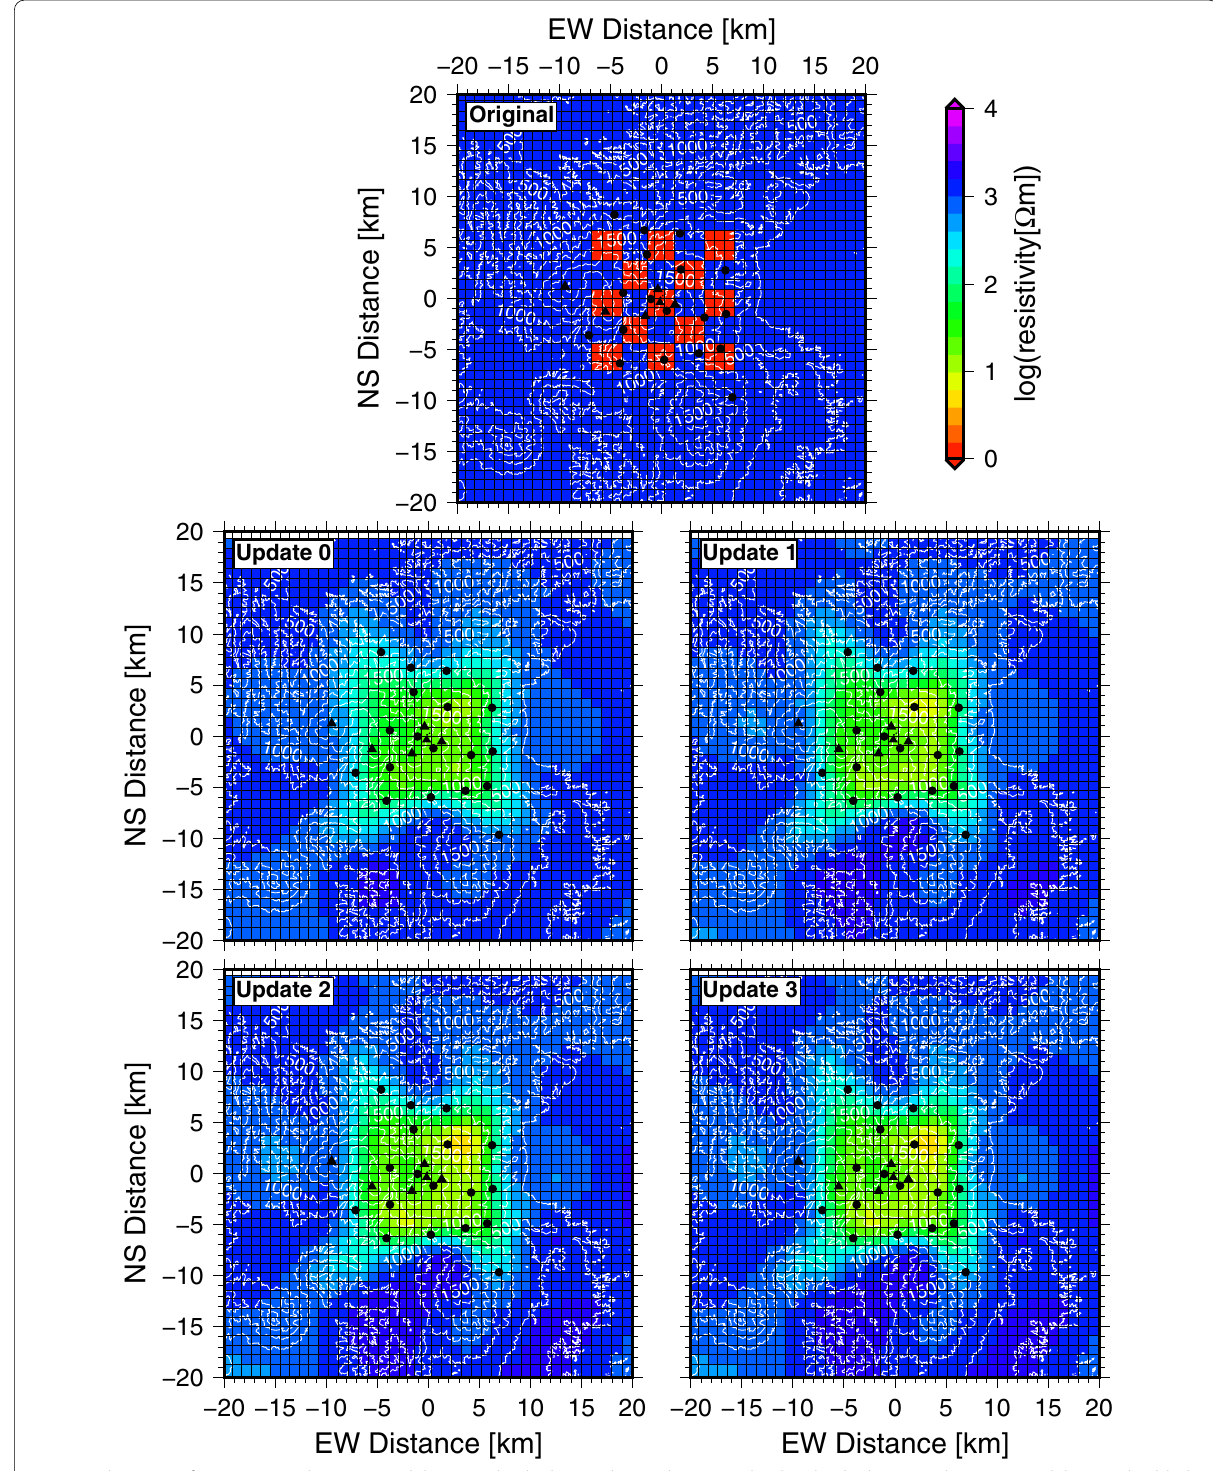
Fig. 10 Plan view of CRT input and output models using checkerboxes about 3 km to a side. The checkerboxes in the input model are embedded in the depth range from 6 to 9 km bsl, and those in the output models are shown at the depth of 7.5 km bsl. Input checkerbox resistivity (red) is 1 Ωm and other blocks are 1000 Ωm except ocean (0.3333 Ωm) and air blocks (10 12 Ωm). The output models are shown at the same number of iterations of the final model at each prior model update. The solid lines show the calculation mesh. The white contour represents surface topography. The NS, EW coordinates are set using Oana Crater’s location as the